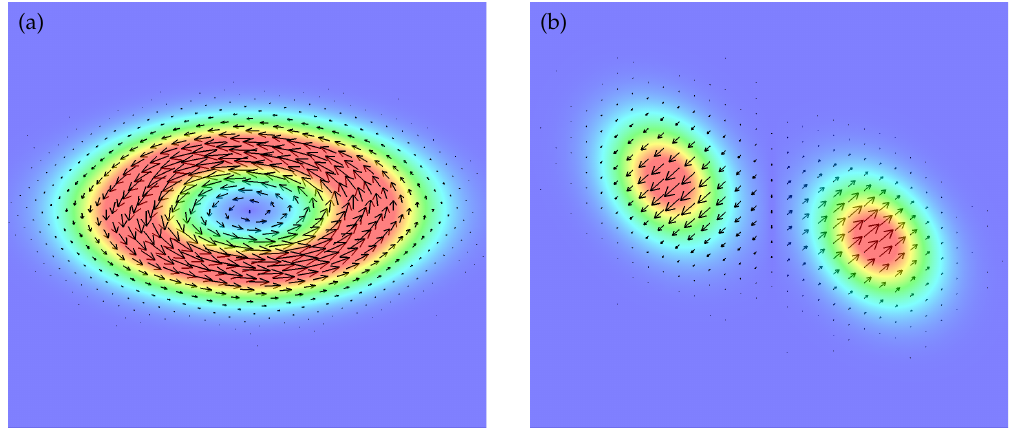
Figure 9. ( a ) xy - and ( b ) yz -cross-sections of a linearly polarized Laguerre-Gaussian wavepacket with orbital angular momentum directed to the positive z -axis.